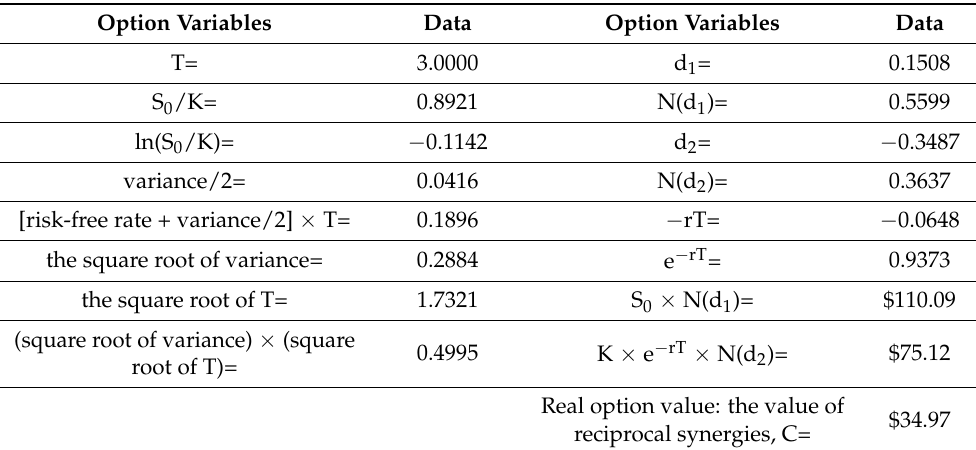
Table 3. Parameters of the Black–Scholes option pricing model and the value of synergies: European call option value (Samsung’s acquisition of Harman, in US$